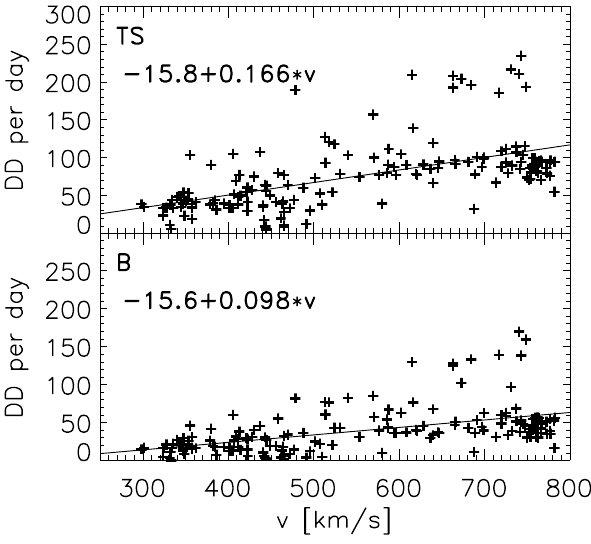
Fig. 4. Distribution of daily averages of DD per day over v (top: TS, bottom: B criterion) with the fit of an linear function.